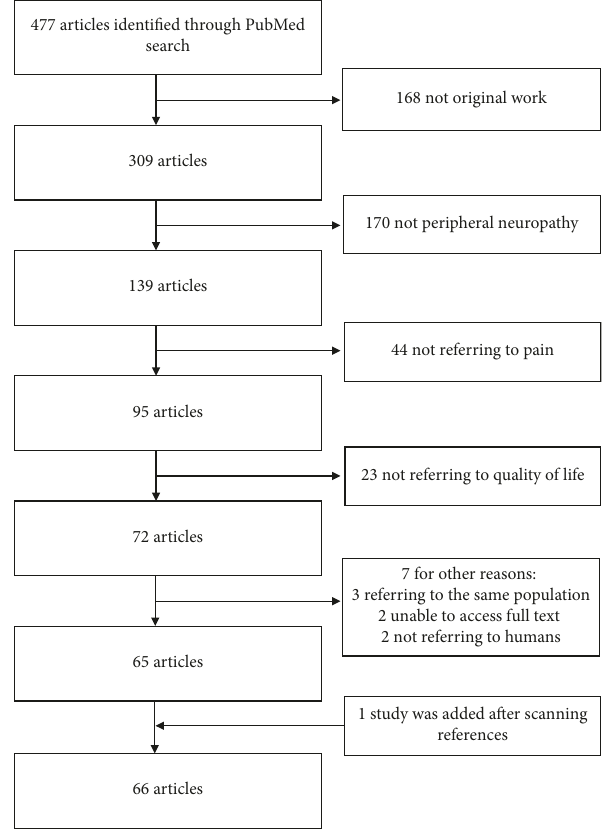
Figure 1: PRISMA